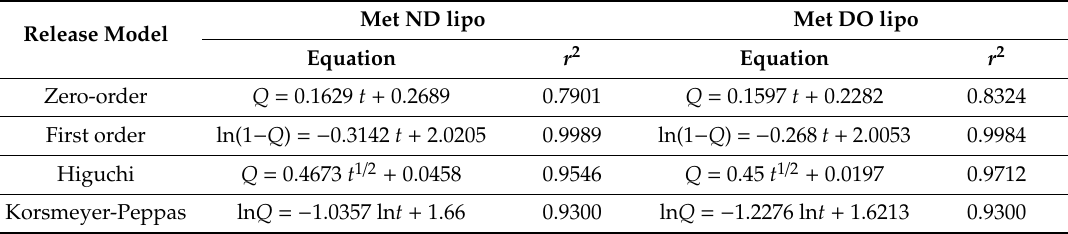
Table 2. Release curve fitting details of Met encapsulated liposomal formulations using various models.